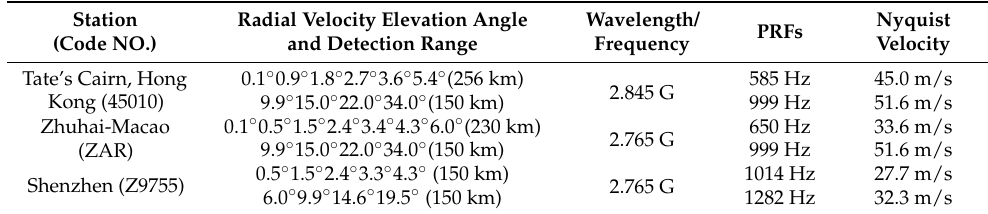
Table 1. Radial velocity observation elevation angles, ranges of three radars in the Pearl River Delta and other radar parameters. Station (Code